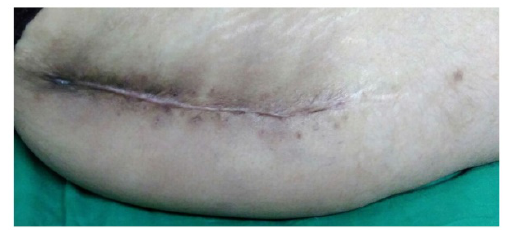
Figure 14. Healed surgical site without active intervention